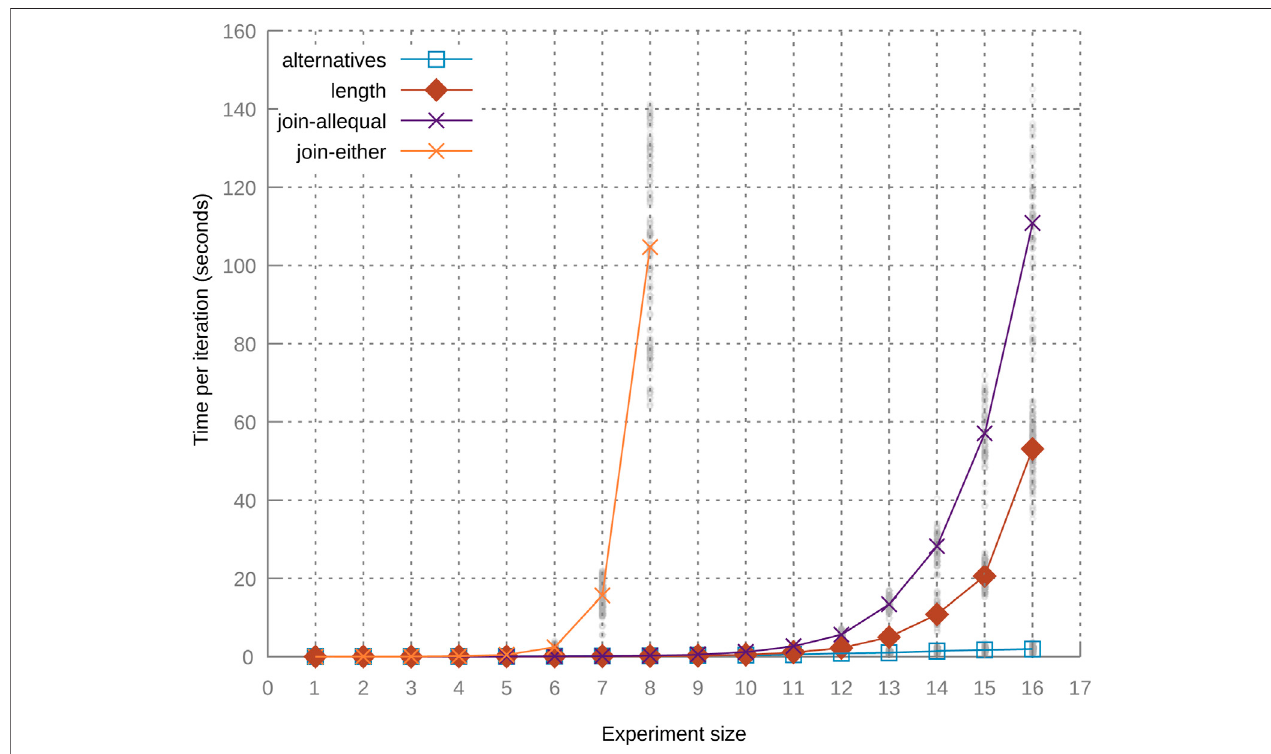
FIGURE 6 | Results of the plan generation time experiments. The lines represent the average value of each measured property, and dots represent individual measurements.